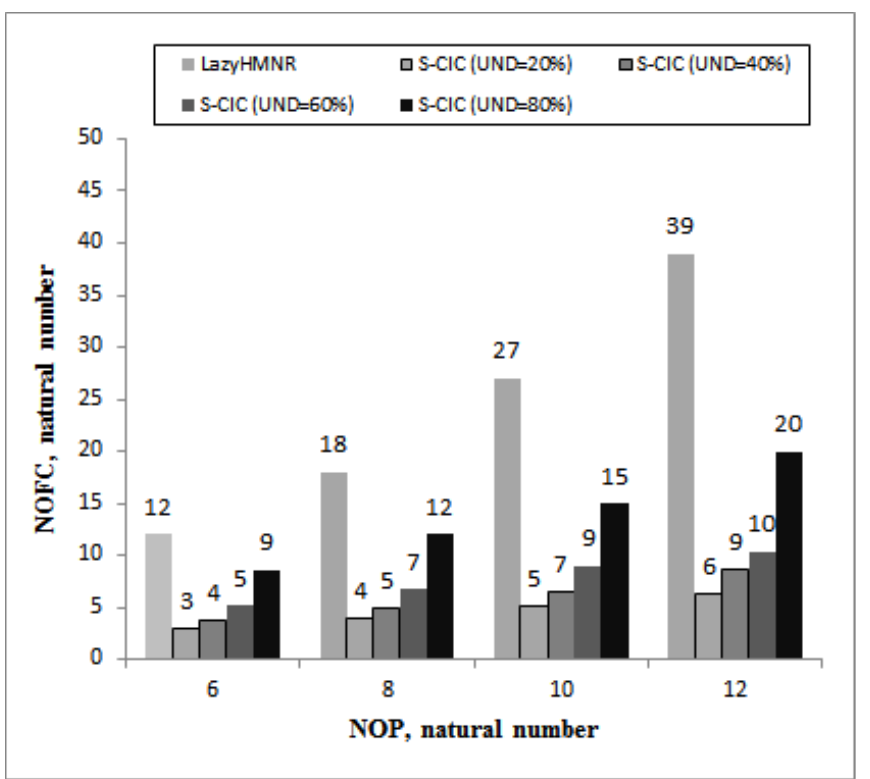
Figure 7. NOFC for the hierarchical